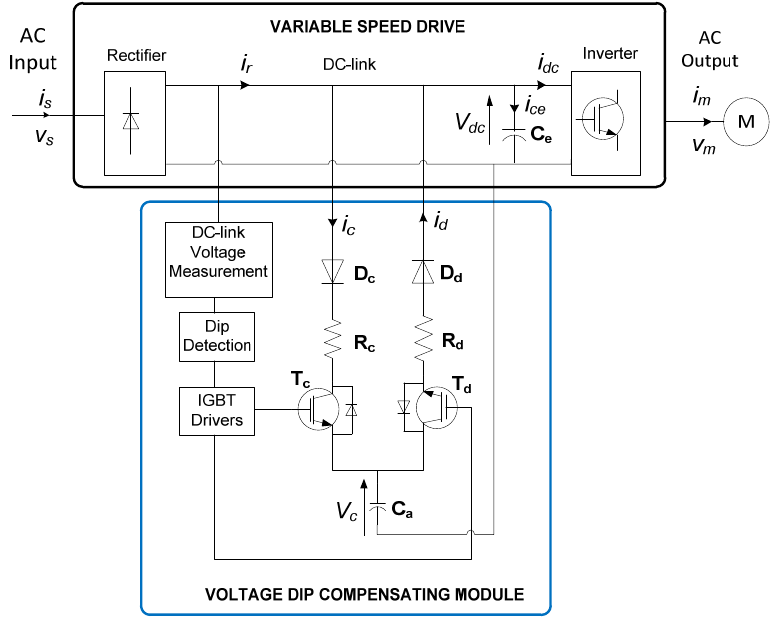
Figure 1. Proposed voltage dip compensating module.